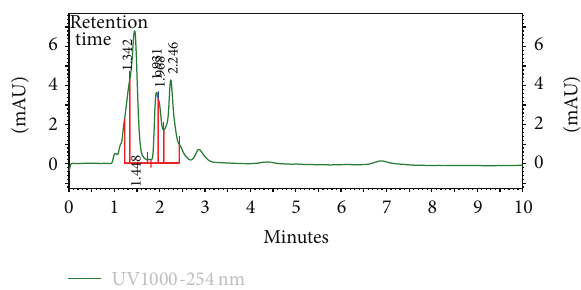
Figure 1: HPLC chromatogram (finger-printing) of methanol leaf extract (KAL) of K. africana at 𝜆 254 nm.